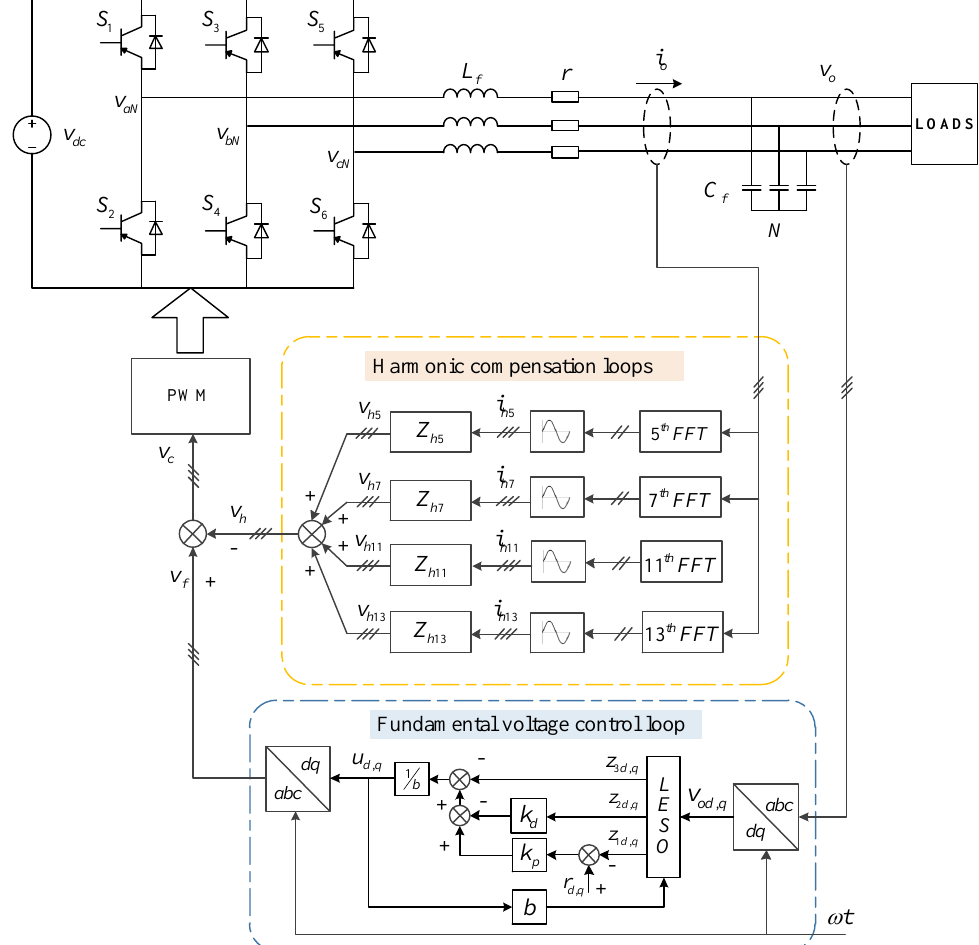
Figure 1. A LC type three-phase three-leg inverter with proposed control